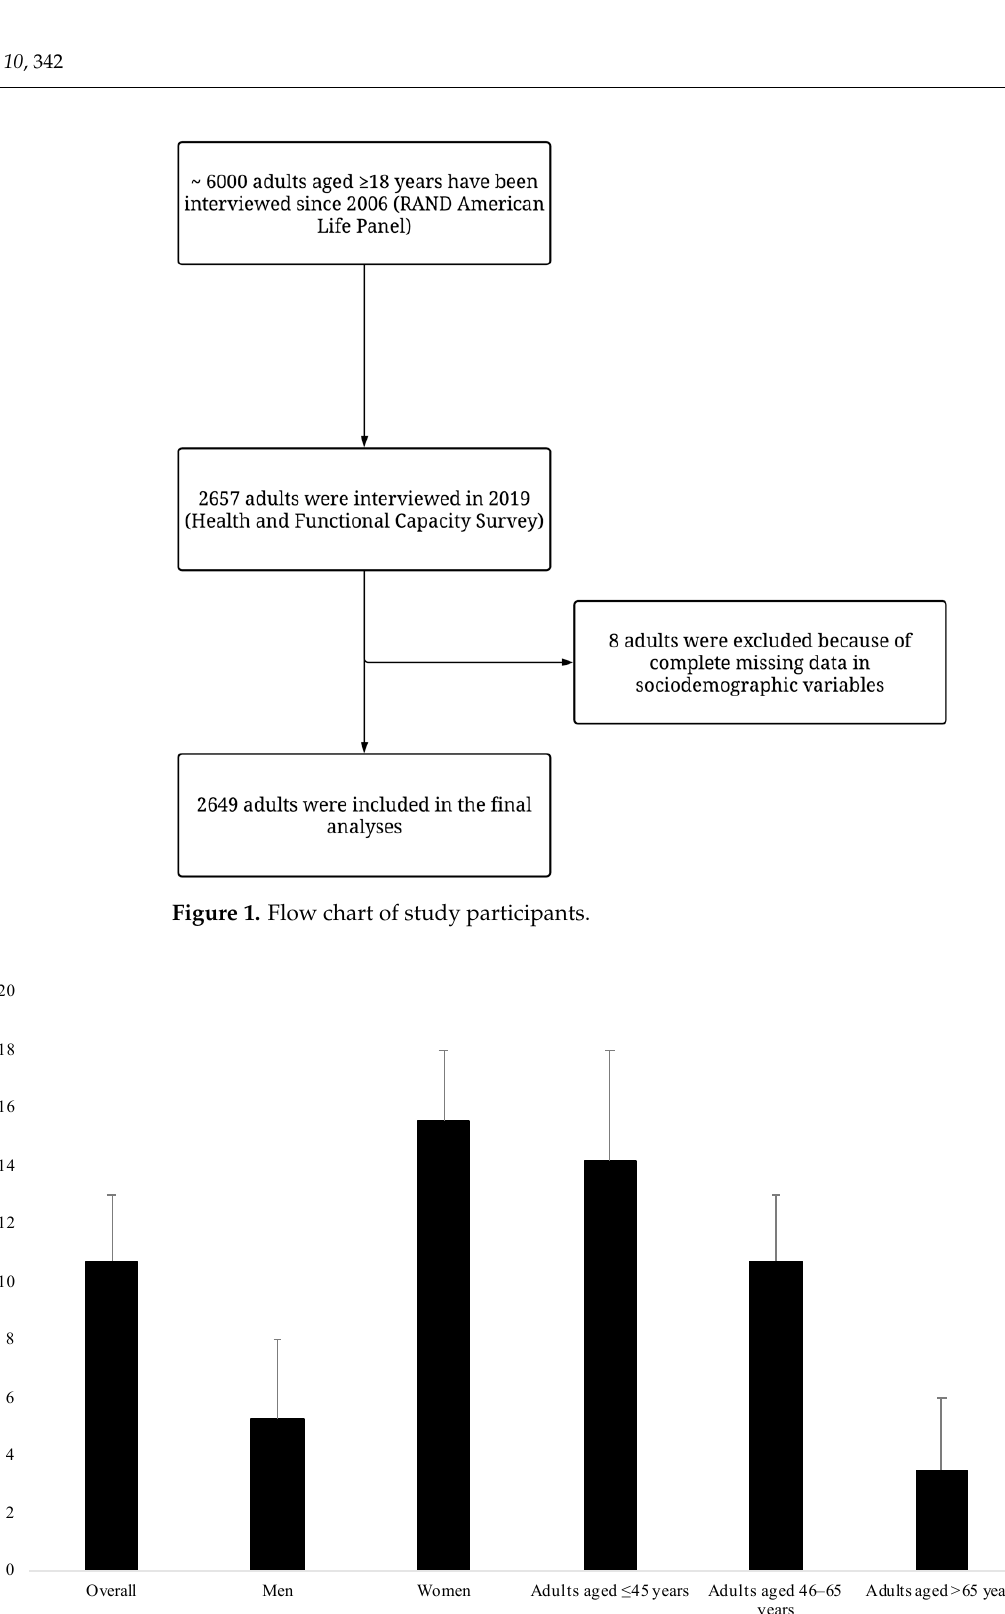
Figure 2. Prevalence of migraine in the overall population and in sex and age subgroups. Migraine was assessed with a yes/no question. The prevalence of migraine was compared between the different sex (i.e., male and female) and age subgroups (i.e., age ≤ 45, 46–65, and >65 years) using chi-squared tests. The p -values were lower than 0.001.